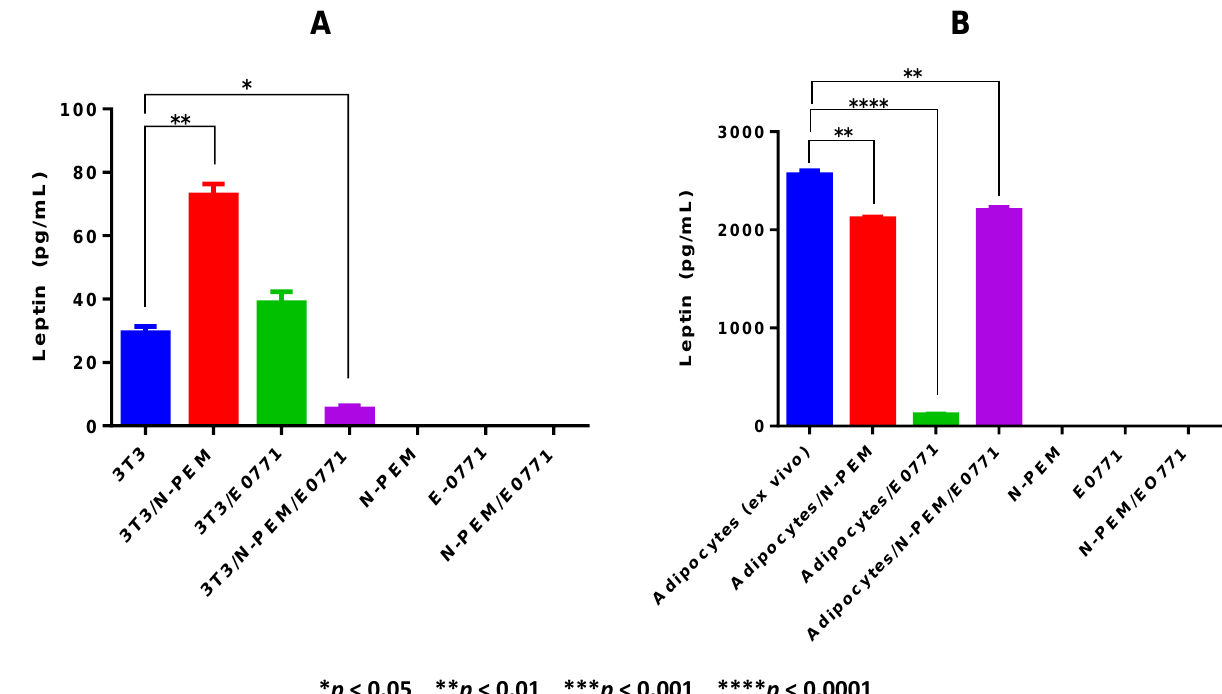
Figure 2. In vitro differentiated adipocytes significantly differ from adipocytes ex vivo isolated from visceral obese adipose tissue in their leptin secretion: leptin is a major marker of obesity and not of adipocyte differentiation. 48 h supernatants from in vitro differentiated ( A ) and ex vivo isolated adipocytes, ( B ) co-cultured with macrophages and tumor cells were analyzed for leptin production using ELISA. Data are representative of one of three independent experiments showing similar results; each sample was tested in